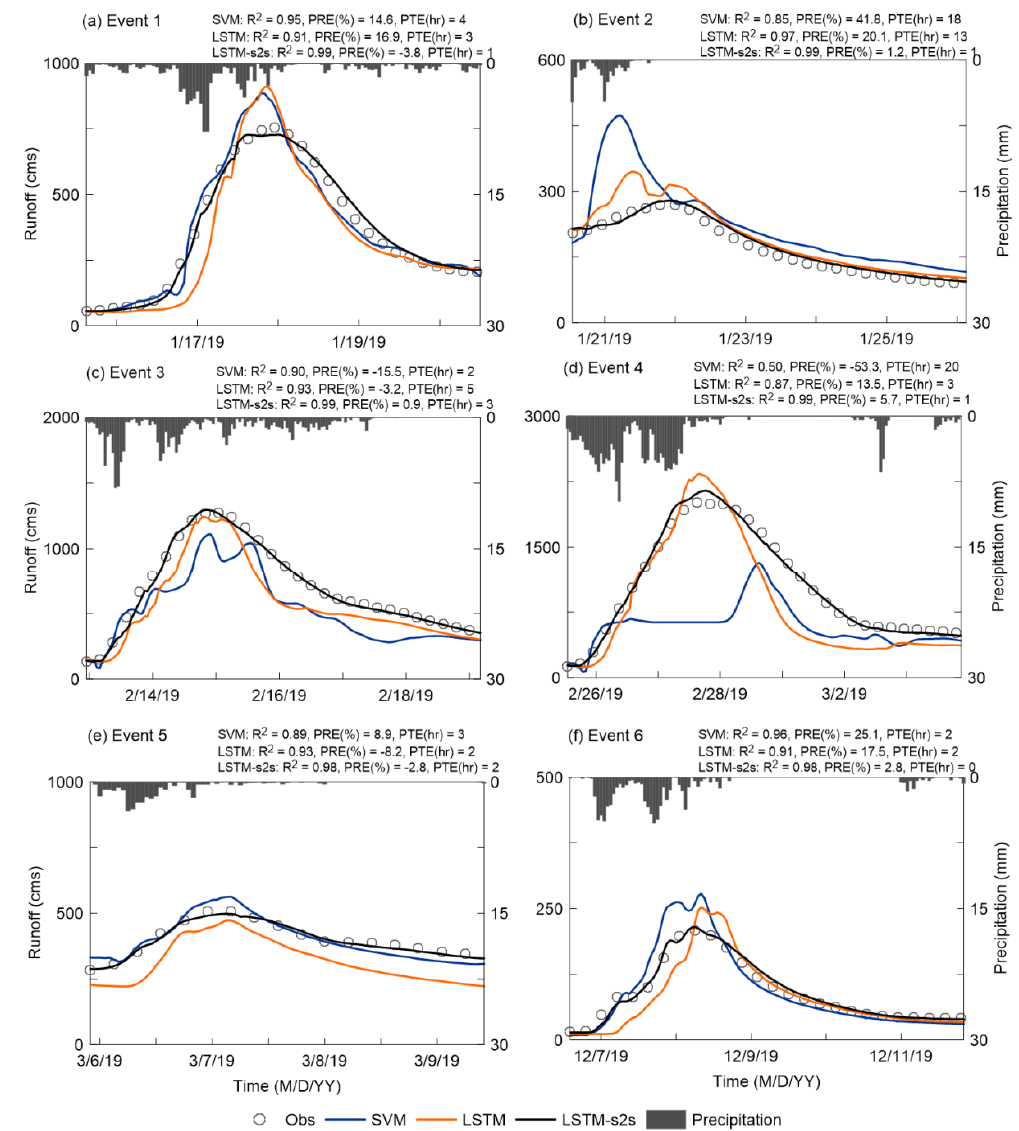
Figure 7. Event-based evaluation results from SVM, LSTM, and LSTM-s2s models. ( a – f ) represent the six events provided from observation and three models.